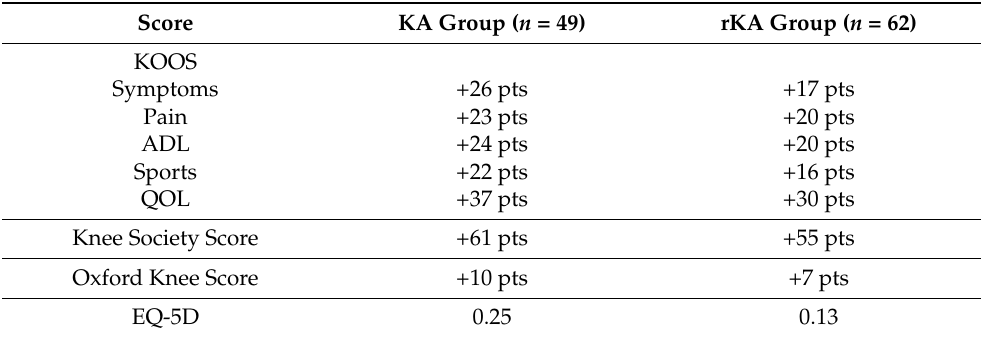
Table 5. Improvement in outcome measurement from pre-operative to 2-months follow-up (delta) for KA and rKA